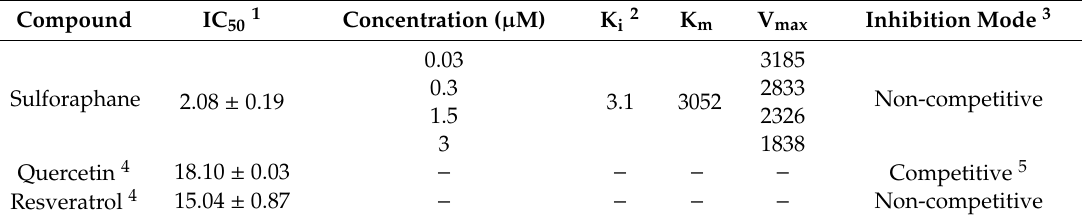
Table 1. Inhibitory e ff ect and kinetic parameters of sulforaphane against BACE1.